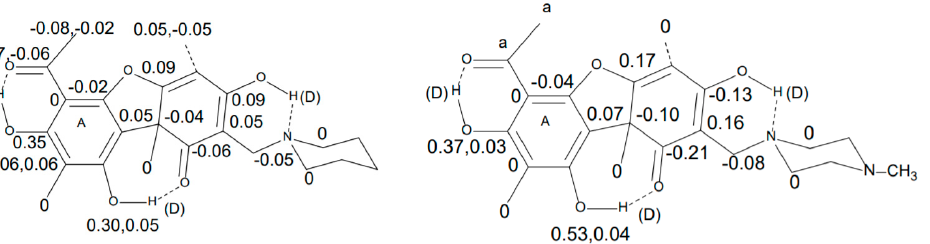
Figure 19. Mannich bases. Deuterium isotope effect on 13 C chemical shifts. Top: In CDCl 3 . Similar effects are observed in a morpholine derivative. Bottom: In DMSO-d 6 . a. refers to the fact that the methyl group is partially deuterated so that the resonance is too complicated for analysis. The structure shown is only one of the tautomers. Reprinted with permission from Ref. [49]. Copyright 2018 Wiley.